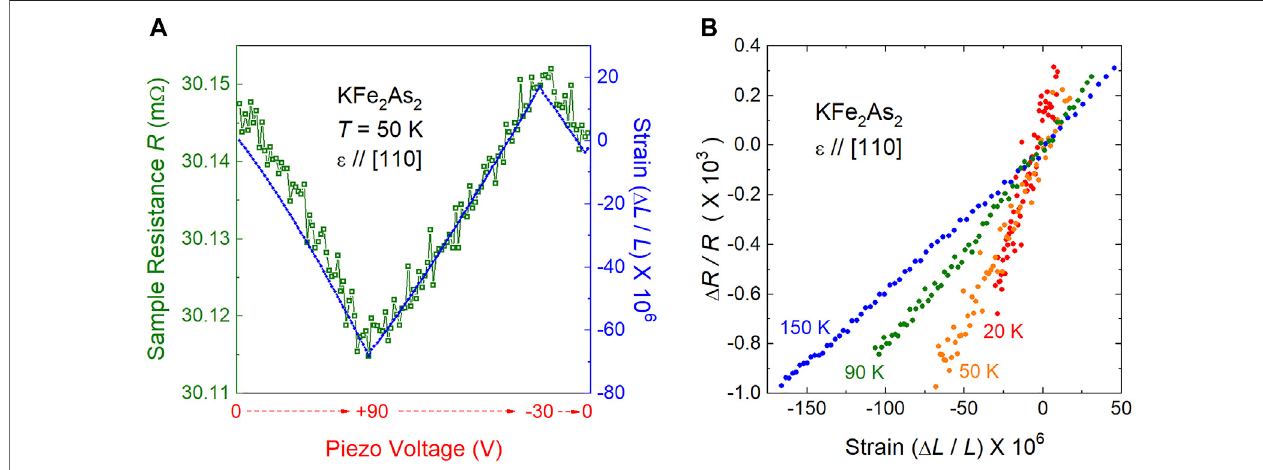
(A) Resistance and strain change according to the voltage applied across the 2 As 2 .